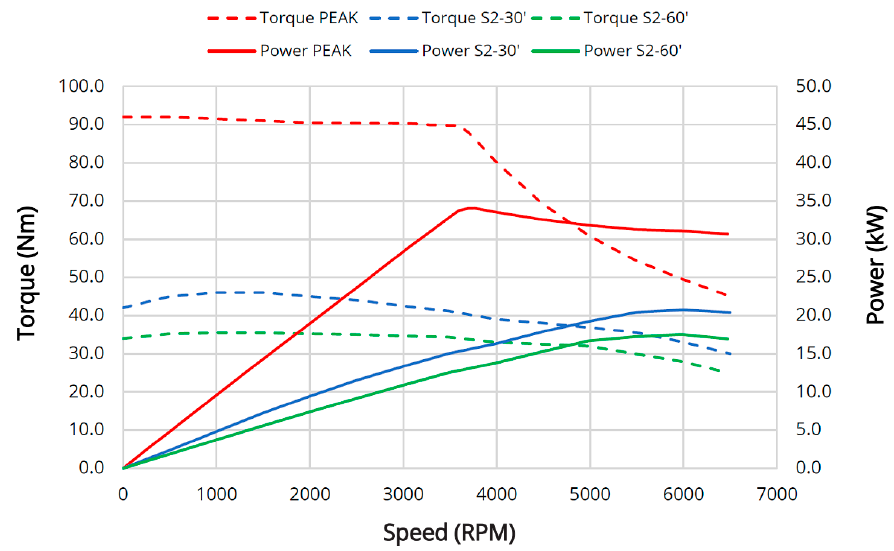
Figure 6. Measured loading characteristics of the drive. Depicted curves are shown for three cases: PEAK—short-term motor loading, ca. tens of seconds; S2-30 ′ —motor loading for a maximum of 30 PEAK—short-term motor loading, ca. tens of seconds; S2-30 (cid:48) —motor loading for a maximum of min; S2-60 ′ —motor loading for a maximum of 60 min (author: Petr Procházka). 30 min; S2-60 (cid:48) —motor loading for a maximum of 60 min (author: Petr Proch á